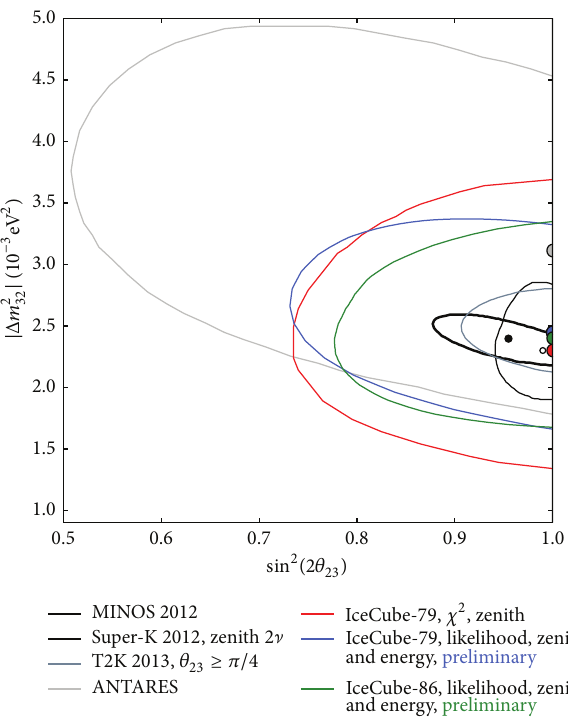
Figure 5: 90% C.L. contours from recent measurements of the neutrino oscillation parameters by ANTARES [22] and IceCube [25, 28, 29] compared to earlier measurements by MINOS [30] and Super-Kamiokande [31] (figure kindly provided by S. Euler, Aachen